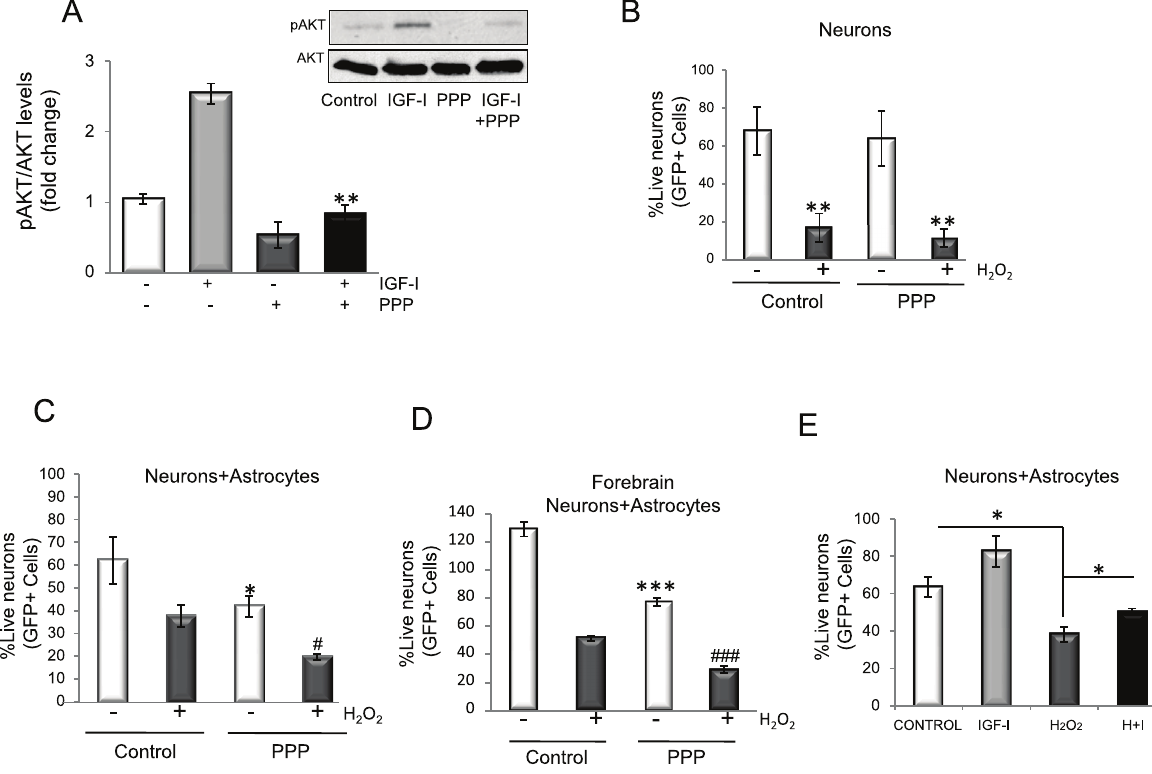
Figure 2. Endogenously produced IGF-I protects neurons against oxidative injury. A ) The IGF-IR inhibitor PPP blocks IGF-I signalling in astrocytes. Astrocytes were treated with 120 nM PPP 1h before adding IGF-I while pAkt levels were measured 10 minutes after adding IGF-I. Ratios are shown in histograms (2 way ANOVA, IGF-I and PPP interaction: p<0.01, F=33.07; IGF-I p<0.01, F=27.38; PPP p<0.001, F=112.3; post-hoc: **p<0.01 vs. IGF-I alone). Representative blot is shown. B ) Blockade of IGF-IR signalling with PPP in neurons cultured alone does not affect H O toxicity after 3–4 days of exposure (2 way ANOVA, H 2 2 hoc: **p<0.01 vs. respective controls). Note that PPP alone does not affect neuronal survival. C ) Viability of cerebellar neurons co-cultured with forebrain astrocytes decreased significantly when treated with PPP for six days. PPP treatment in the presence of H viability even further (2 way ANOVA,